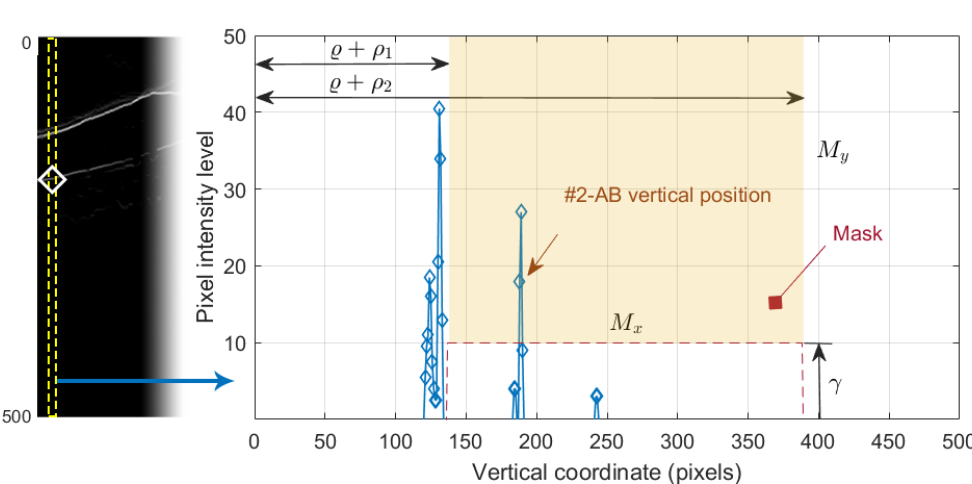
Figure 9. Selection of the #2-AB vertical position. On the left, the positive vertical gradient image I #2 On the right, 1D profile of the dashed column of I #2